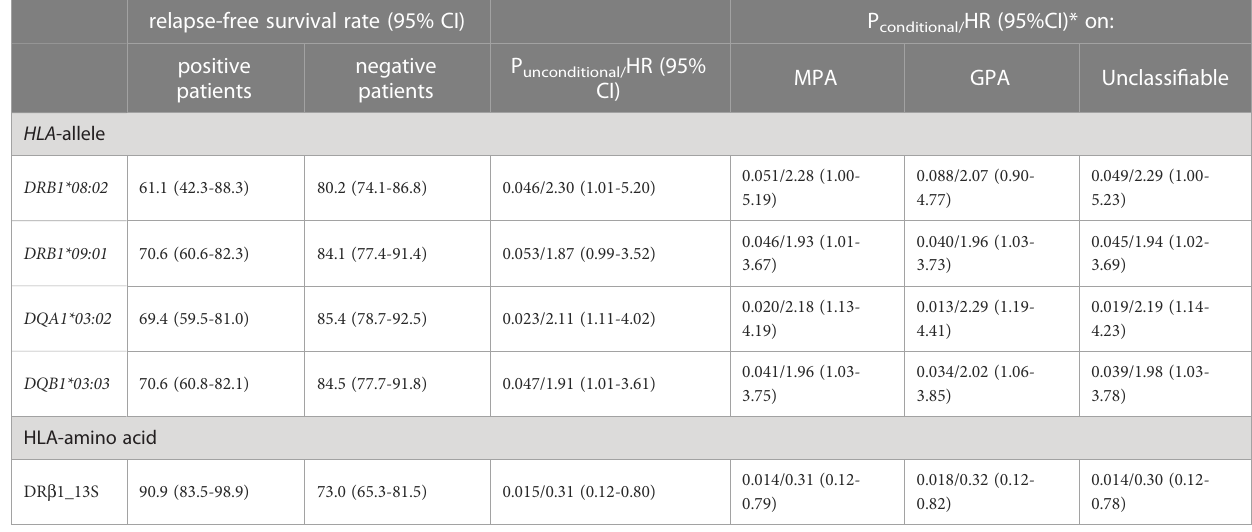
TABLE 5 Association of HLA class II alleles and DR b 1 position 13 serine with risk of relapse in multivariate Cox proportional hazards model. relapse-free survival rate (95% CI) P conditional/ HR (95%CI)* on: